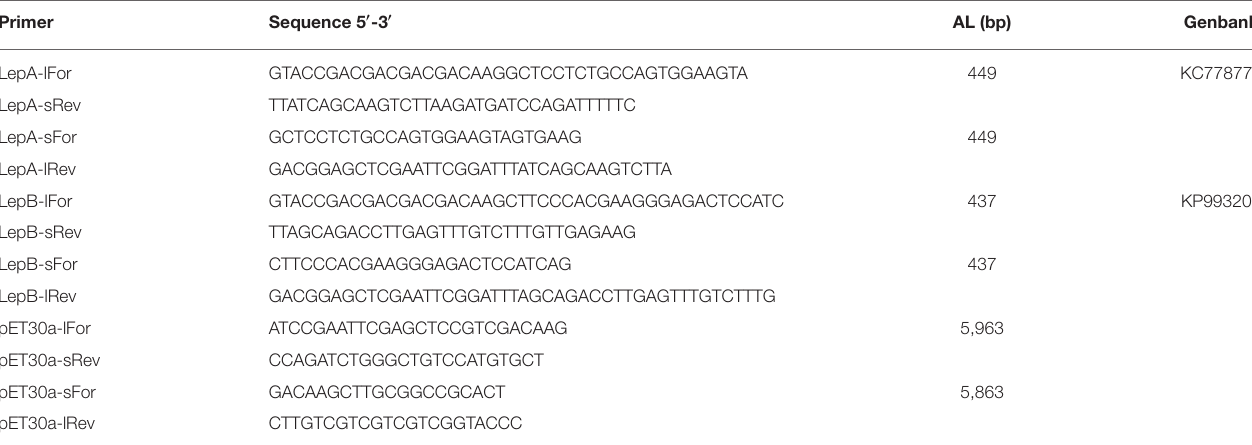
TABLE 1 | Primers of recombinant plasmids